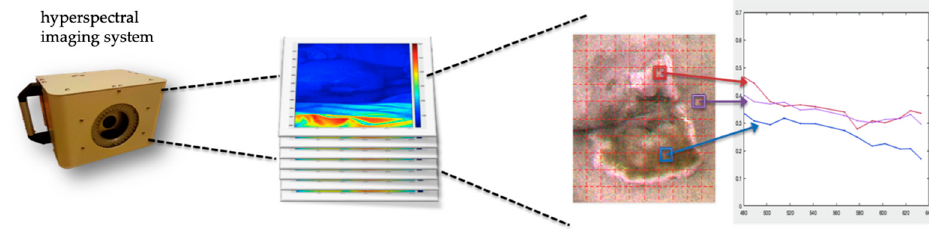
Figure 1. Hyperspectral Imaging (HSI) technology.